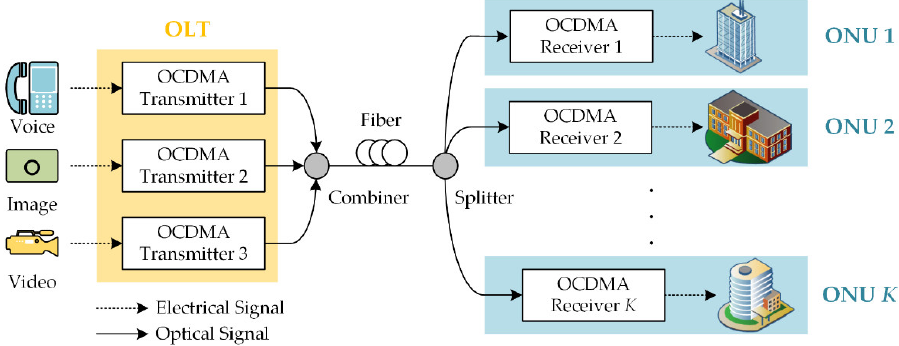
Figure 3. Passive optical network (PON) topology based on OCDMA for downstream communications. OLT: optical line terminal; ONU: optical network unit.